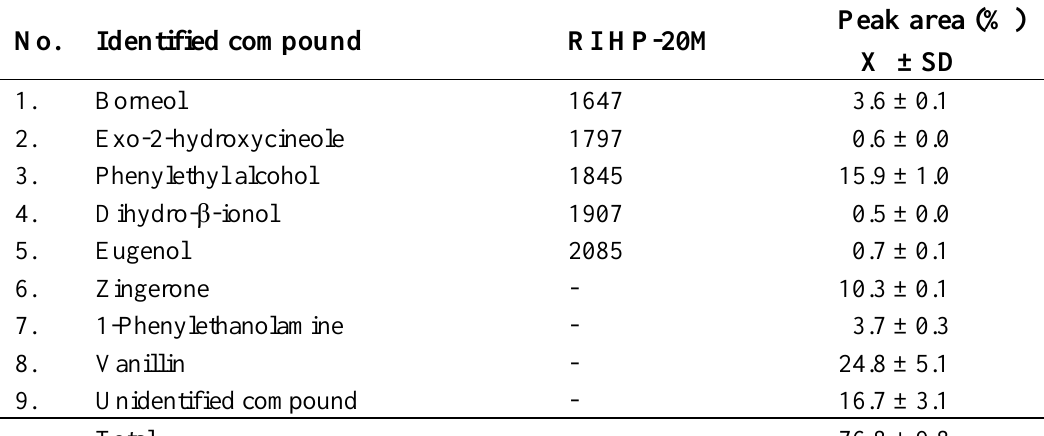
Table 1. Chemical composition of free volatile aglycones isolated from Bosnian